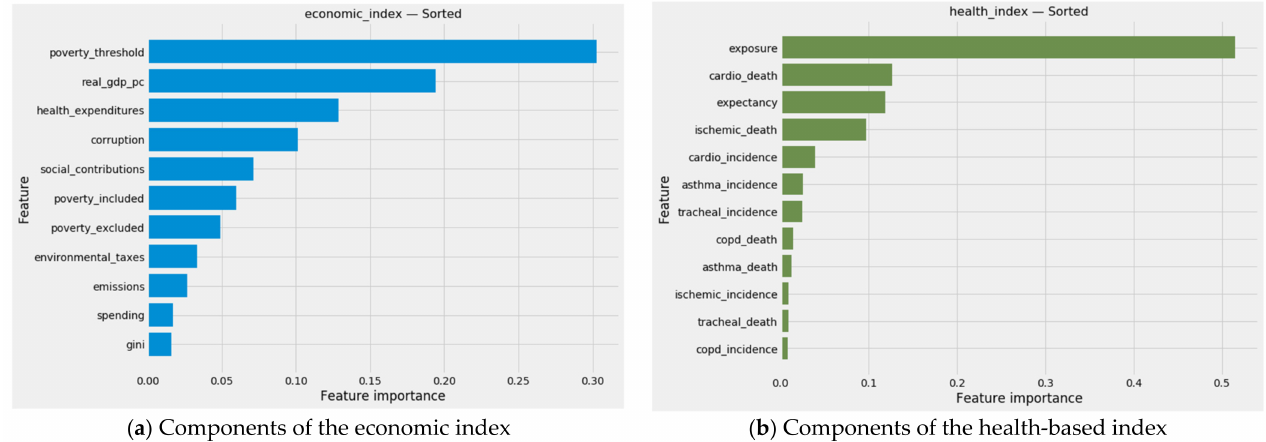
Figure 15. Individual components of the PCA-generated economic and health-based indexes: ( a ) the economic index; ( b ) the heath-based index.